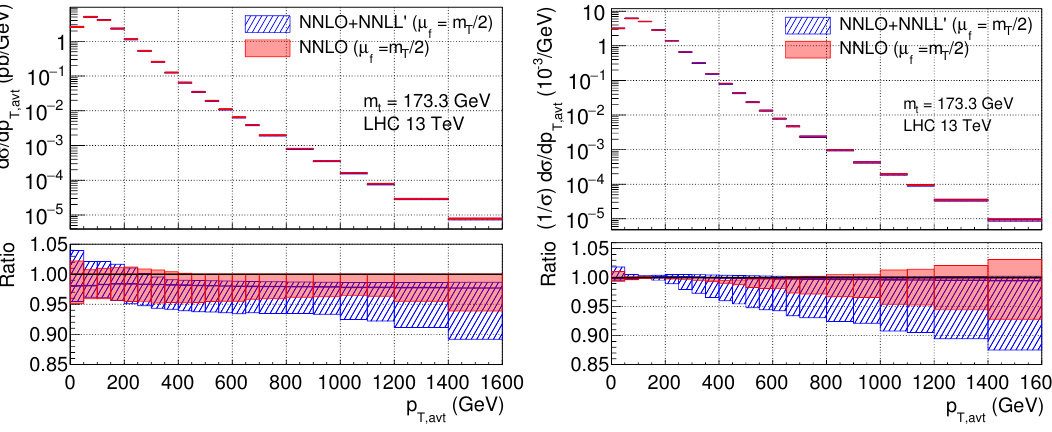
Figure 6 . Results for the absolute (left) and normalized (right) p T; avt distributions at the LHC with p s = 13 TeV. In all cases the ratio is to the NNLO result with (cid:22) f = m T = 2. Uncertainty bands are obtained in complete analogy to those in (cid:12)gure